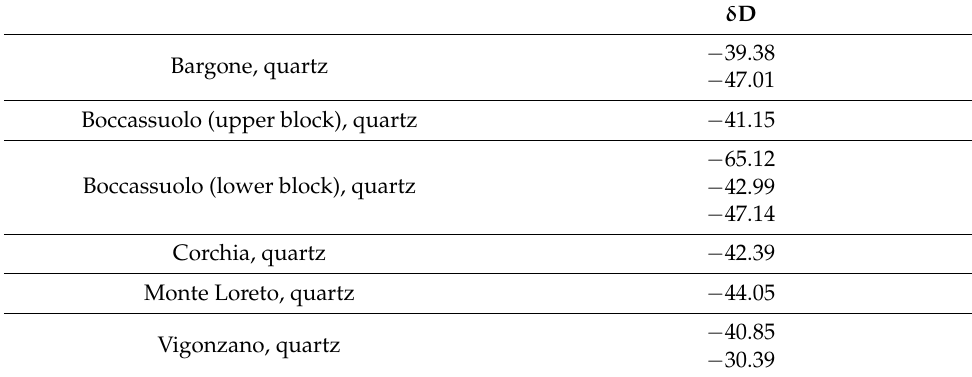
δ D − 39.38 − 47.01